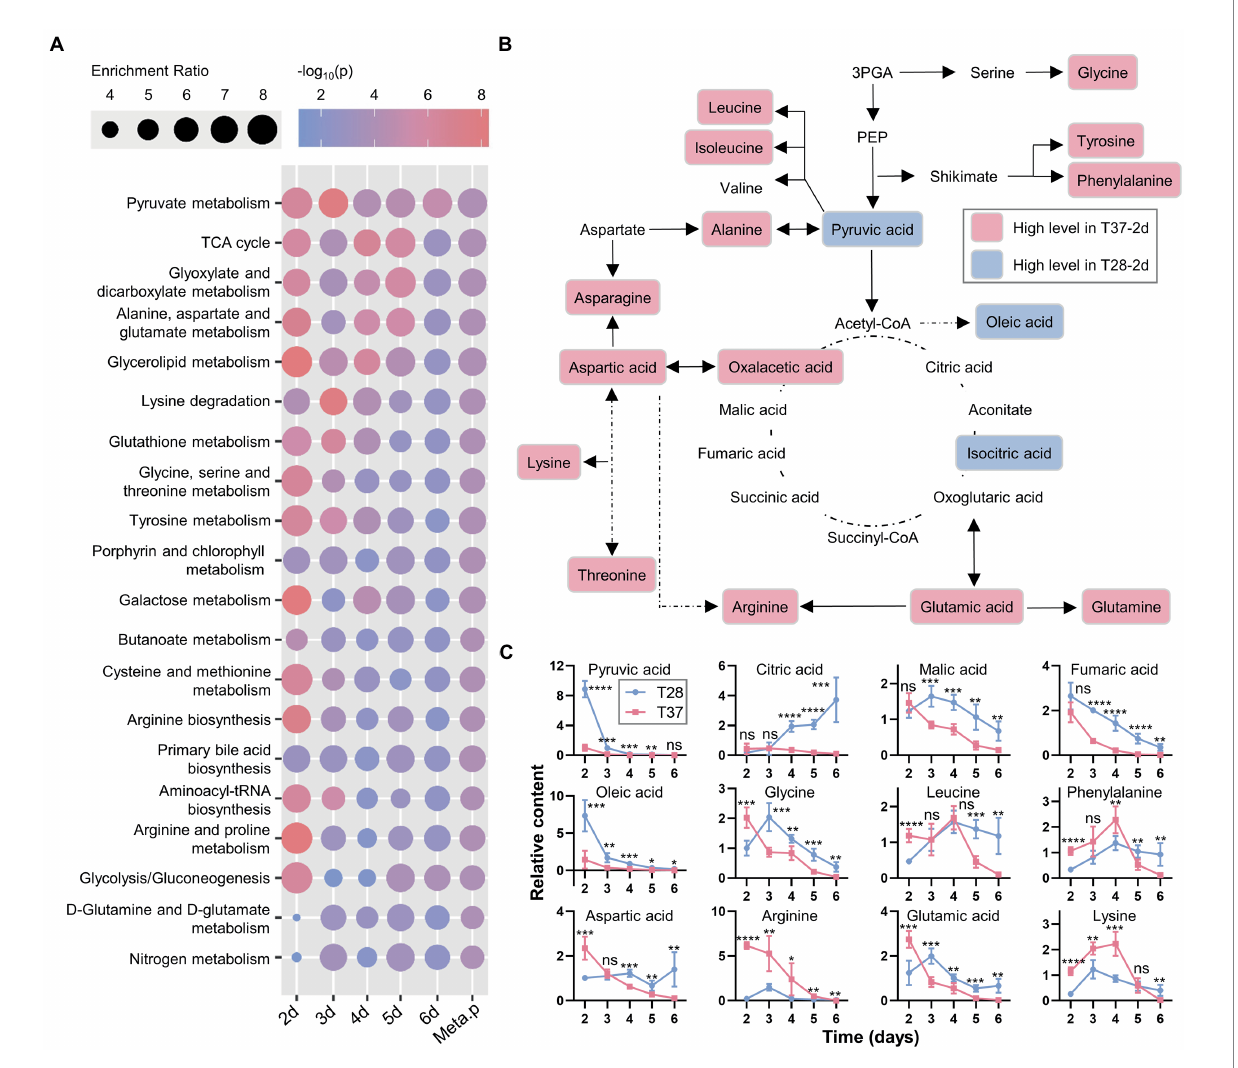
FIGURE 3 Pathway analysis and meta-analysis between the T28 and T37 mycelia samples. (A) Enrichment analysis and pathway meta-analysis of differentially accumulated primary metabolites. The enriched pathways were ranked using the pathway-level p -values (Meta.p). (B) An overview of metabolites involved in primary metabolism, showing the differences in metabolite levels among the T28-2d and T37-2d samples. (C) The relative content curves of primary metabolites. Significance was determined by the t-test. * p < 0.05, ** p < 0.01, *** p < 0.001, **** p <